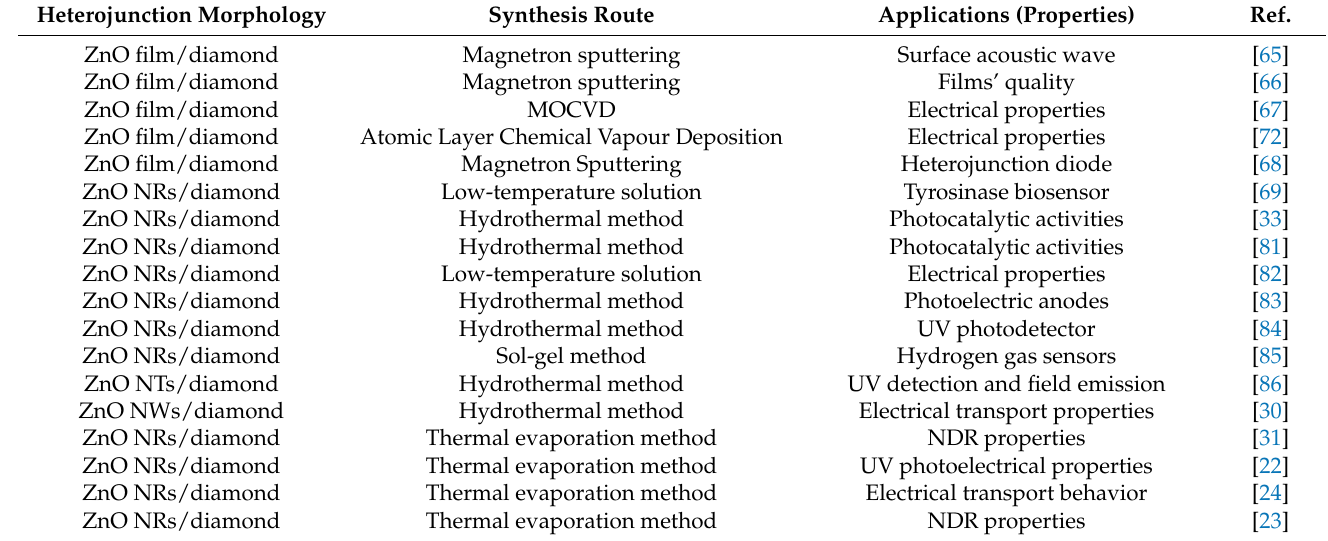
Table 1. Heterojunction applications and properties of 1D